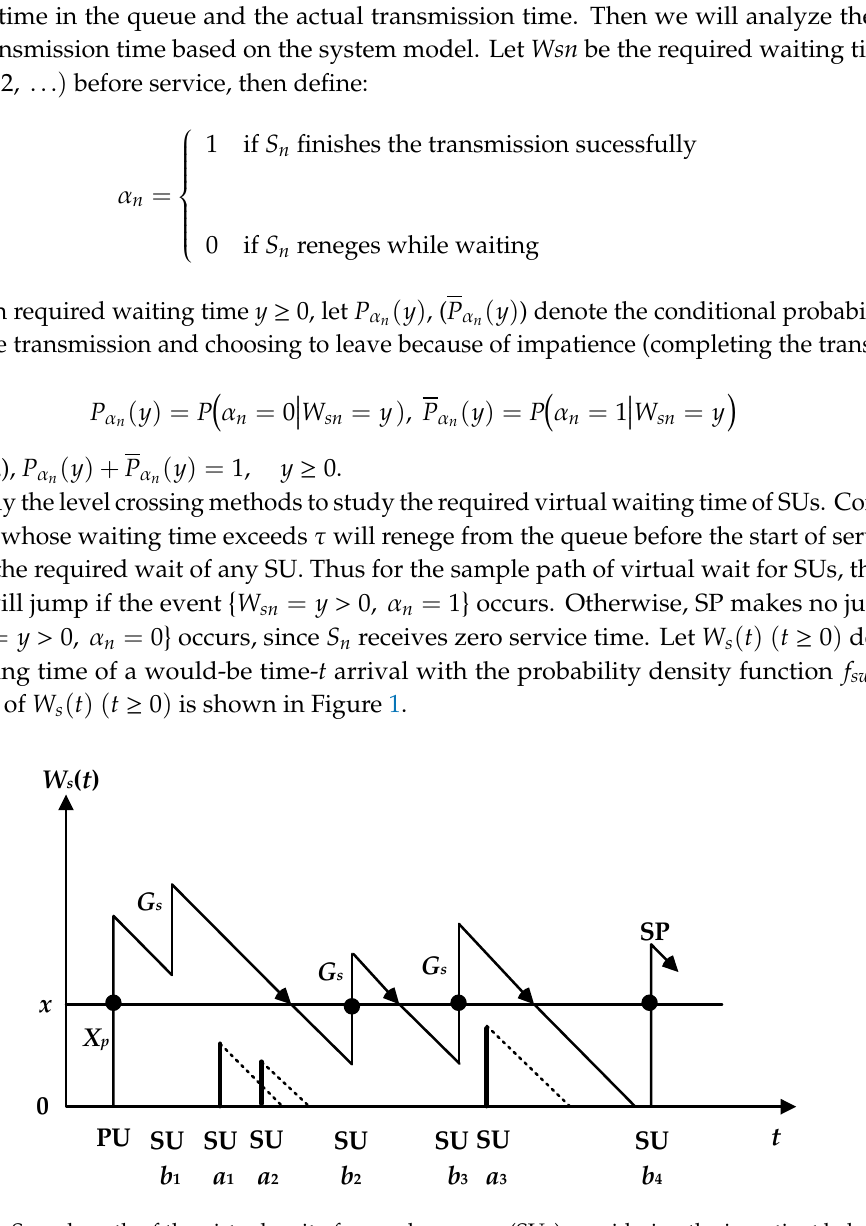
Figure 1. Sample path of the virtual wait of secondary users (SUs) considering the impatient behavior. Assuming renegers arrive at a n and stayers arrive at b n , n = 1, 2, . . . , we denote the actual transmission time of SU by G s , and let Gs ( x ) be the corresponding distribution function. According to